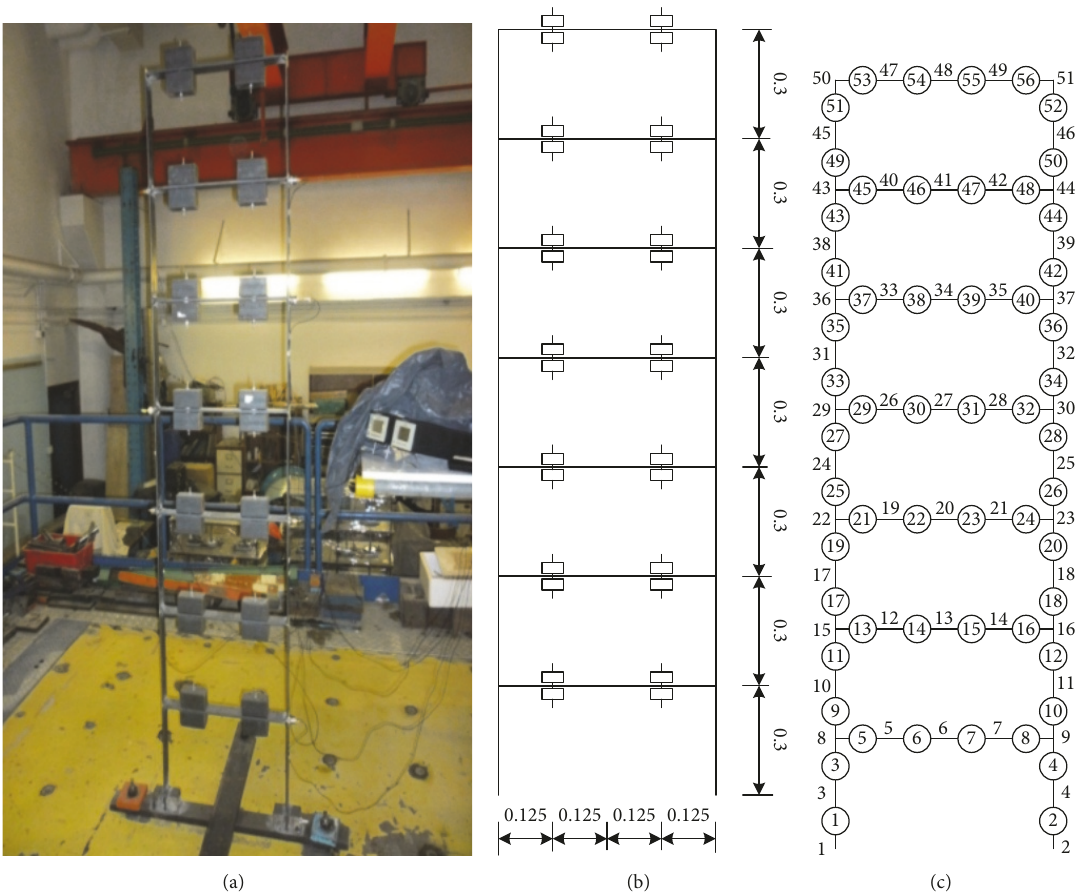
Figure 7: Test model and finite element model. (a) The test model in laboratory. (b) The dimensions of the test model. (c) The element and node numbering system of the finite element model.